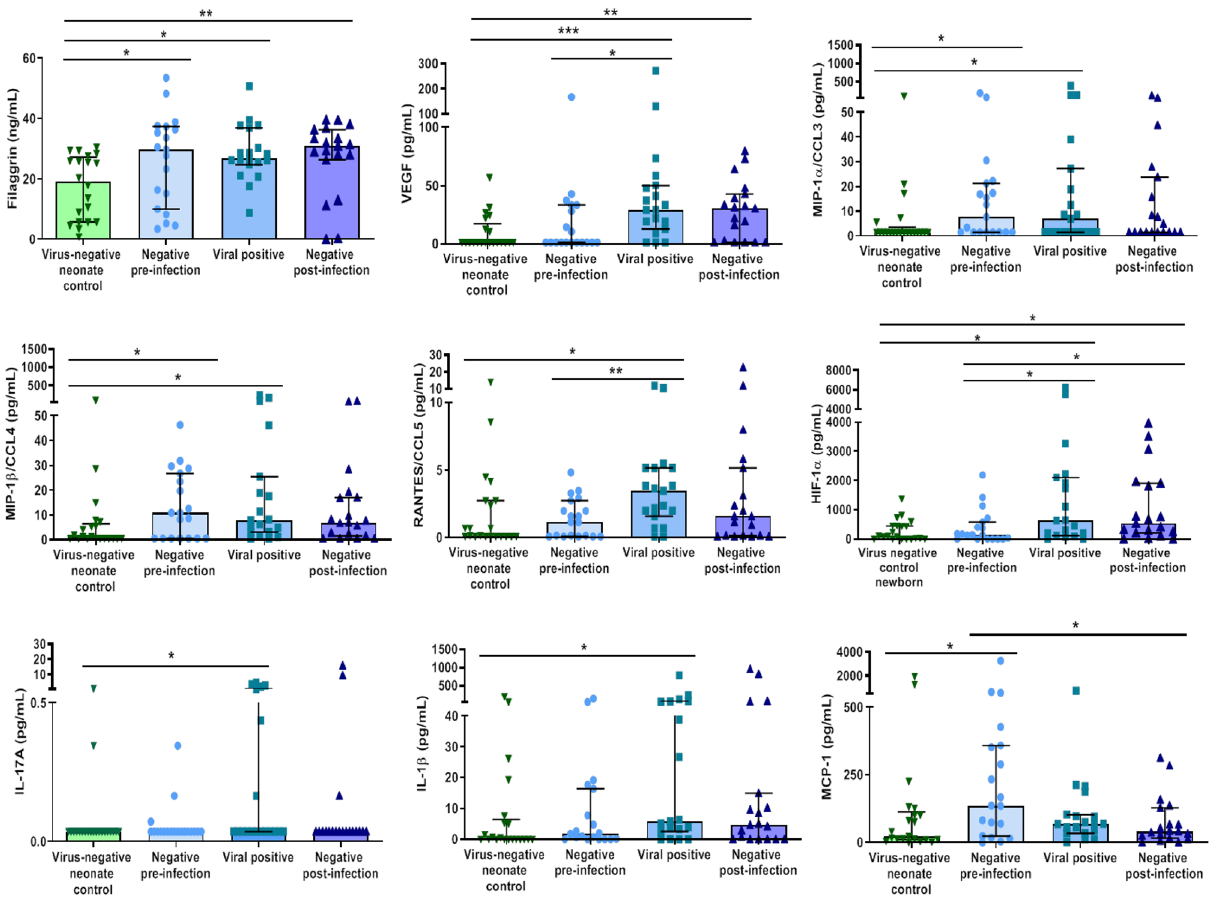
Figure 2. Virus-negative neonate controls have a different molecular profile in their airways compared to the pre-infected and infected neonates. The figure shows protein quantities of filaggrin, VEGF, MIP-1α/CCL3, MIP-1β/CCL4, RANTES/CCL5, HIF-1α, IL-17A, IL-1β, and MCP-1 in samples from virus-negative controls ( n = 21) or negative pre-infection ( n = 19), viral positive ( n = 19), and negative post-infection samples from virus-positive premature neonates ( n = 19) measured by ELISA or Luminex technology. Inter-group analysis was performed using Kruskal–Wallis test with multiple comparisons followed by Dunn’s uncorrected post-test. Bar graphs represent median and interquartile ranges. * P < 0.05; ** P < 0.01 and *** P <